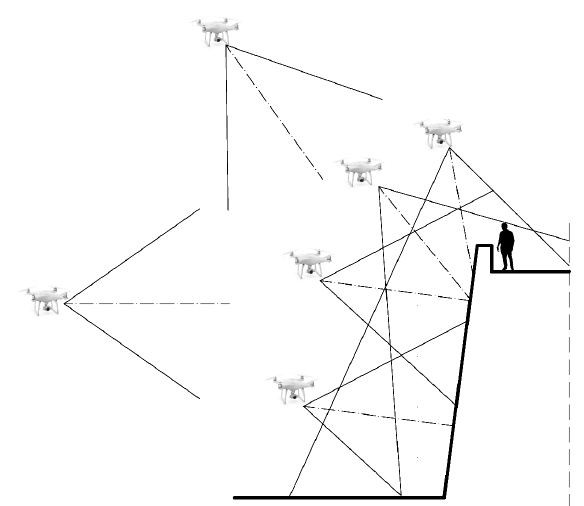
Figure 6. UAV survey positions related to a typical vertical section of the walls.